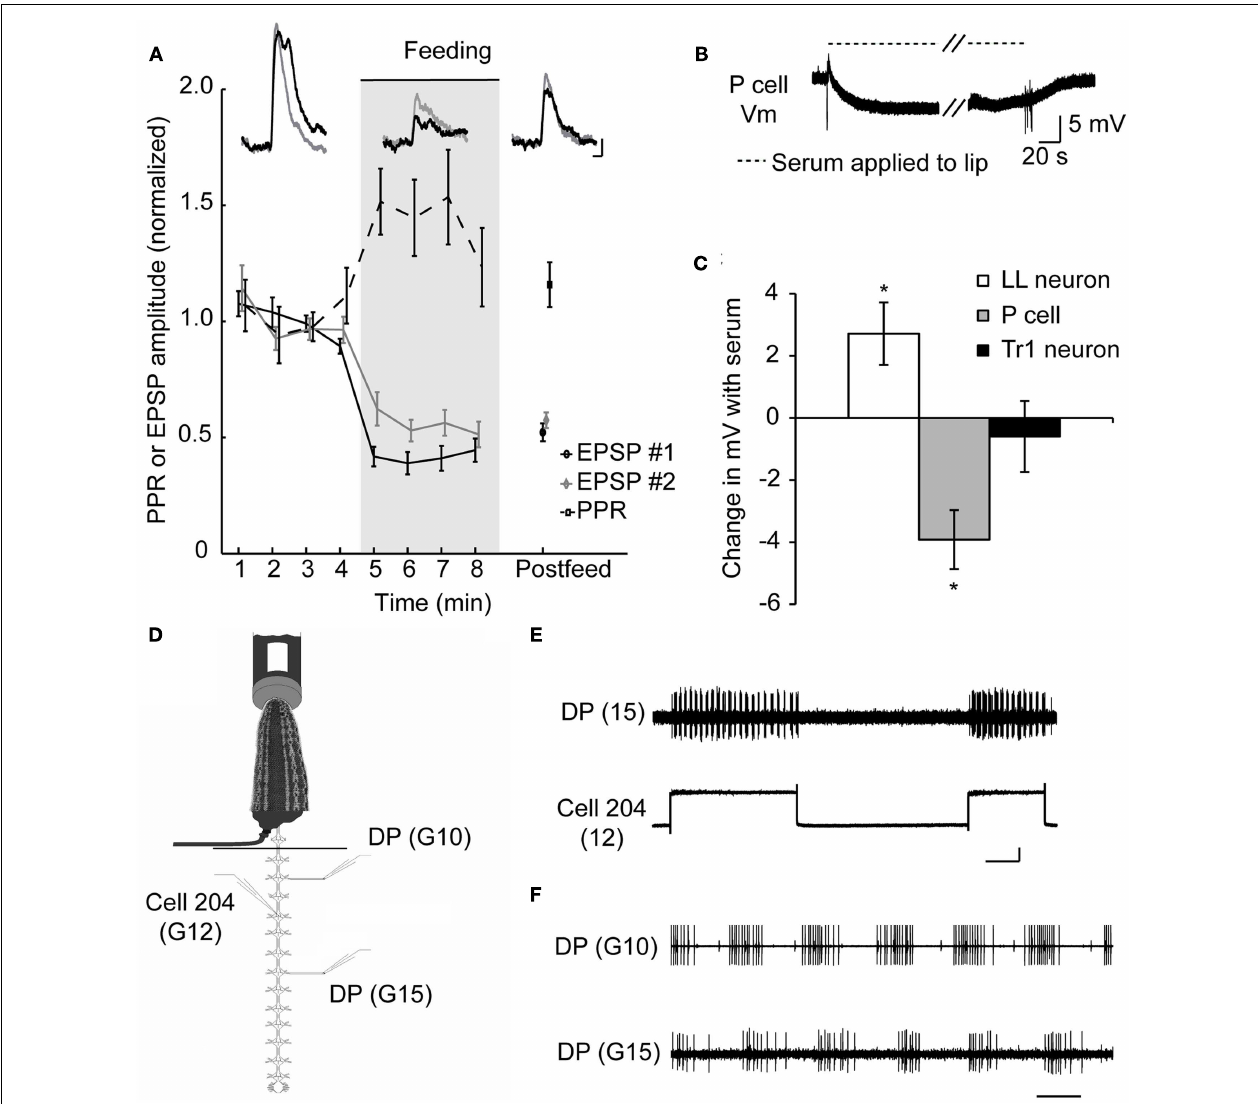
serotonergic motor effector LL cell depolarizes as described previously by others. * p < 0.05, N = 5 leeches. (D) A schematic diagram of semi-intact feeding preparation showing the sites of intracellular stimulation and extracellular recordings. Leeches were fed on warmed bovine serum. Dorsal posterior nerves (DP) contain the axon of a dorsal excitor motor neuron (DE-3) and spiking indicated the dorsal contraction phase of each swim cycle. (E) Depolarization of cell 204 with a 2-nA current elicited a swim pattern in the DP recorded in ganglion 15.Traces were recorded while the anterior end of the leech was feeding from the serum tube.The vertical scale bar represents 50mV and the horizontal scale bar represents 5s. Cell 204 spikes are small ( ∼ 5mV) and are obscured by the relatively large depolarization caused by an inability to completely offset the electrodes resistance while passing large currents. (F) DP nerve recordings made anterior and posterior to the impaled 204 cell in (E) . Scale bar represents 500ms. (Data from Gaudry and Kristan,